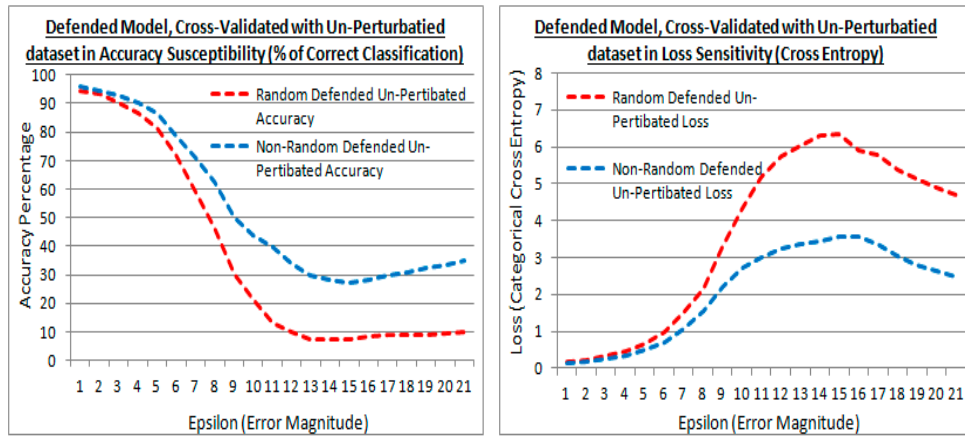
Figure 14. Accuracy and losses of a defended model with epsilon increments against the original non-attack cross-validation dataset, for both the existing (random) and proposed (non-random) methods.